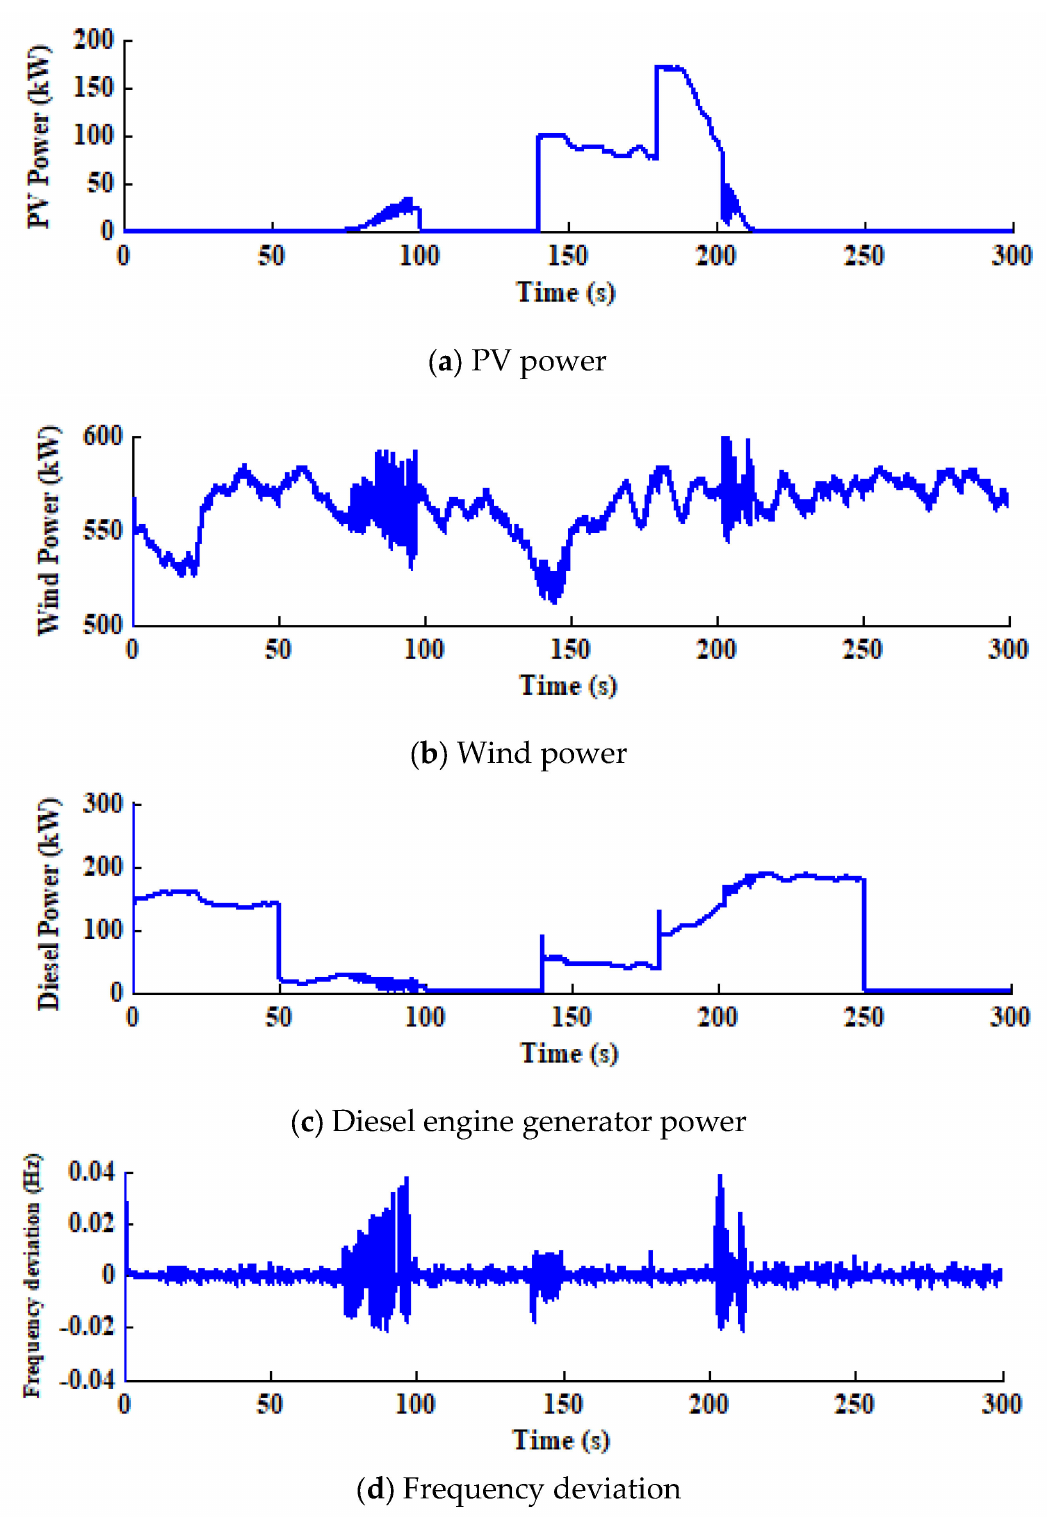
Figure 10. The simulation results for scenario 1B under the high penetration level of the